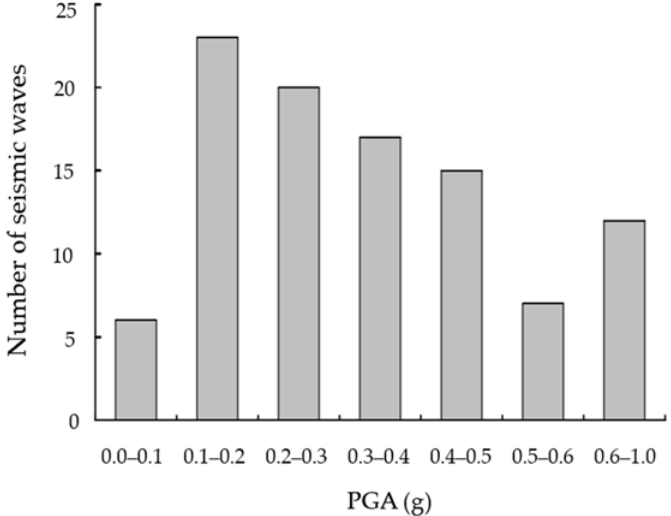
Figure 4. PGA distribution near-fault ground motion record.